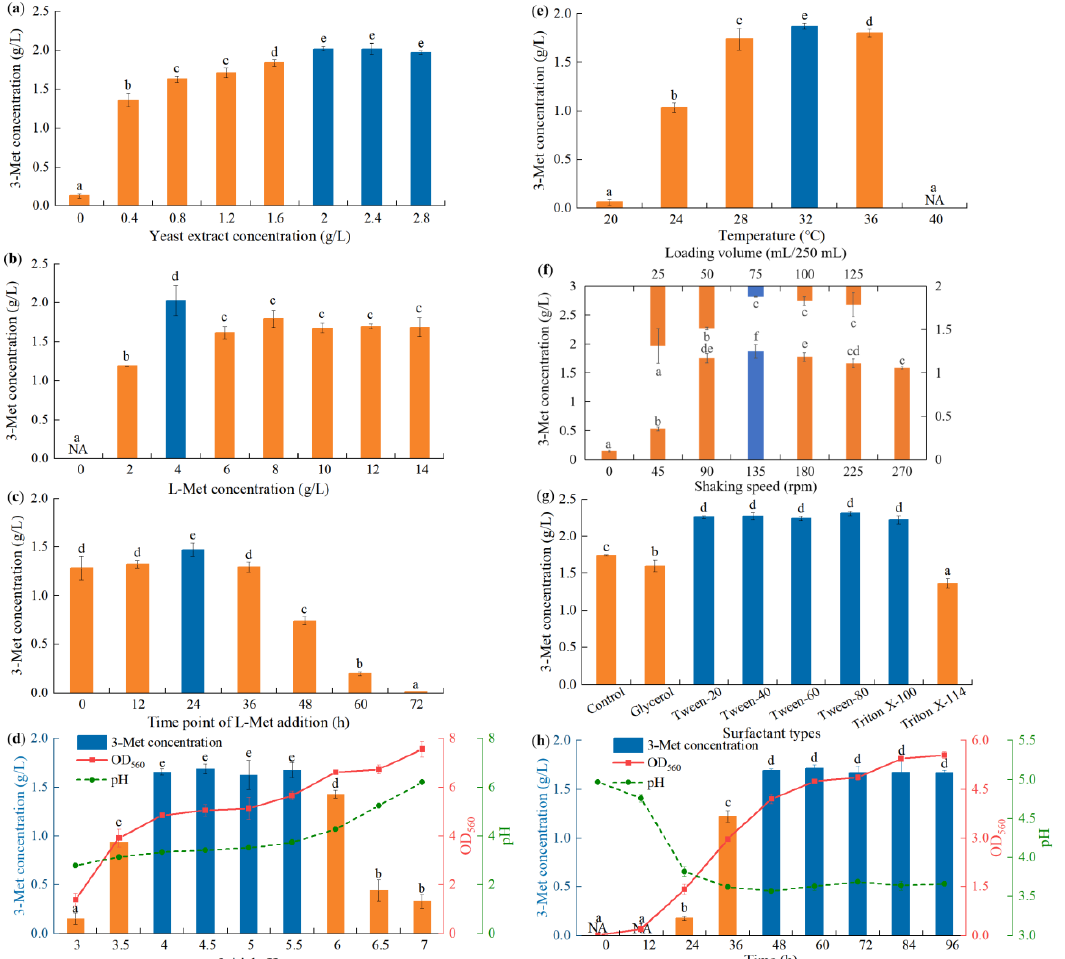
Figure 2. Effect of yeast extract concentration (0, 0.4, 0.8, 1.2, 1.6, 2.0 and 2.4 g/L) ( a ), L-Met concentration (0, 2, 4, 6, 8, 10, 12 and 14 g/L) ( b ), time point of L-Met addition (0, 12, 24, 36, 48, 60 and 72 h) ( c ), initial pH (3.0, 3.5, 4.0, 4.5, 5.0, 5.5, 6.0, 6.5 and 7.0) ( d ), temperature (20, 24, 28, 32, 36 and 40 °C) ( e ), shaking speed and loading volume (0, 45, 90, 135, 180, 225, 270 rpm and 25, 50, 75, 100 and 125 mL/250 mL) ( f ), surfactant types (control, glycerol, Tween-20, Tween-40, Tween-60, Tween-80, Triton X-100 and Triton X-114) ( g ) and time (0, 12, 24, 36, 48, 60, 72, 84 and 96 h) ( h ) on 3-Met concentration. Same letters in the column indicates that the data do not differ significantly at 5% probability by Tukey’s test.